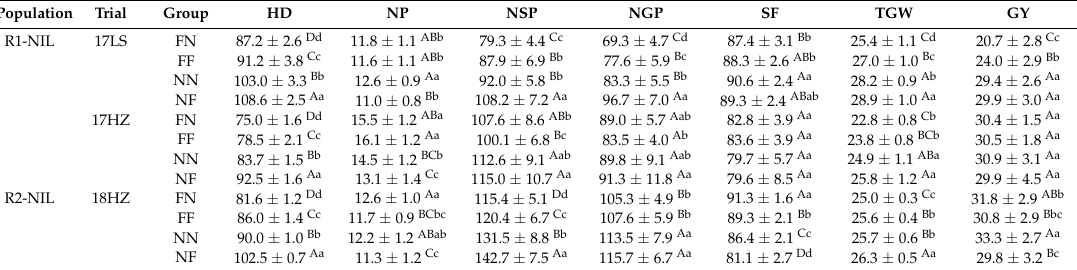
FN, Hd1 ZS97 ghd7 ZS97 ; FF, Hd1 ZS97 Ghd7 MY46 ; NN, hd1 MY46 ghd7 ZS97 ; NF, hd1 MY46 Ghd7 MY46 . Values are mean ± sd. Uppercase and lowercase letters following the values represent significant differences at p < 0.01 and p < 0.05, respectively, based on Duncan’s multiple range